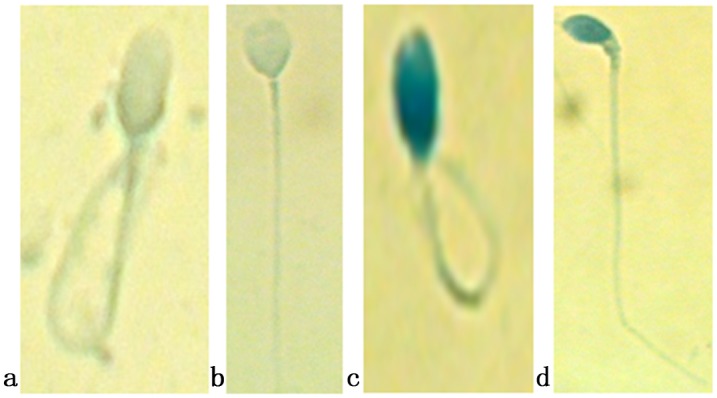
The hypo-osmotic swelling test and aniline blue (AB) staining (HOS/AB) of the same sperm.Patterns observed for the HOS/AB test: (a) AB1, sperm unstained and swollen tails; (b) AB2, sperm unstained and unswollen; (c) AB3, sperm darkly stained and swollen tails; (d) AB4, sperm darkly stained and unswollen.